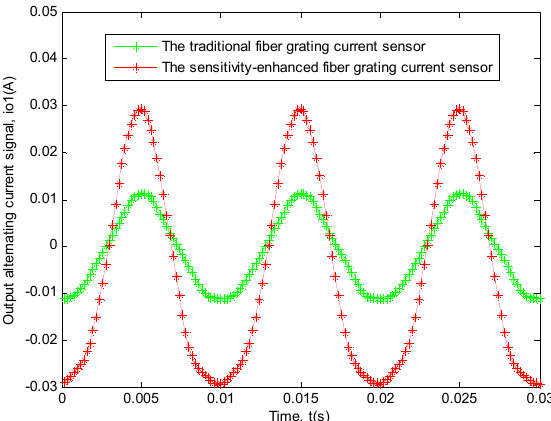
Figure 8. This experiment result of the two sensors between output alternating current signal ( i o 1 ) and time ( t ). The red curve shows the relationship of the sensitivity-enhanced fiber grating current sensor. The green curve shows the relationship of the traditional fiber grating current sensor.